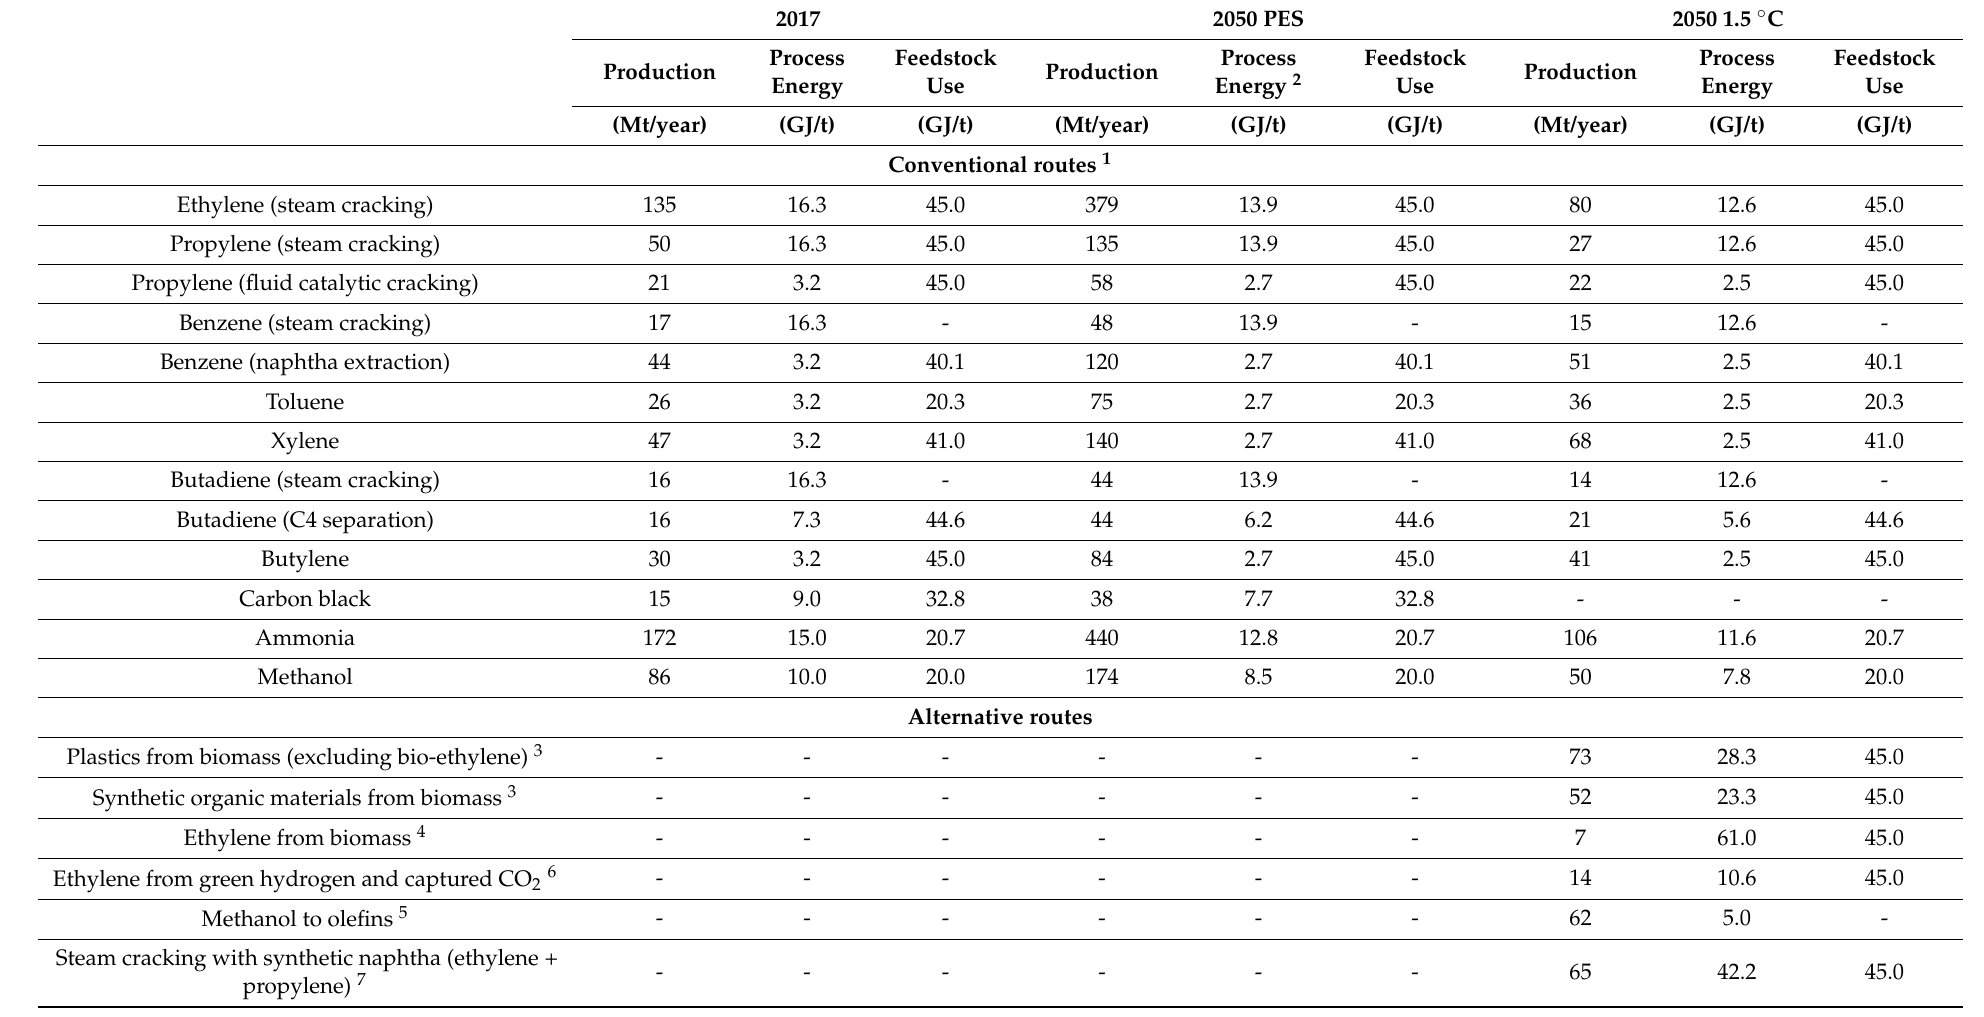
Table 4. Global production volumes and the specific fuel and feedstock use of the assessed chemicals in final energy terms, 2017 and